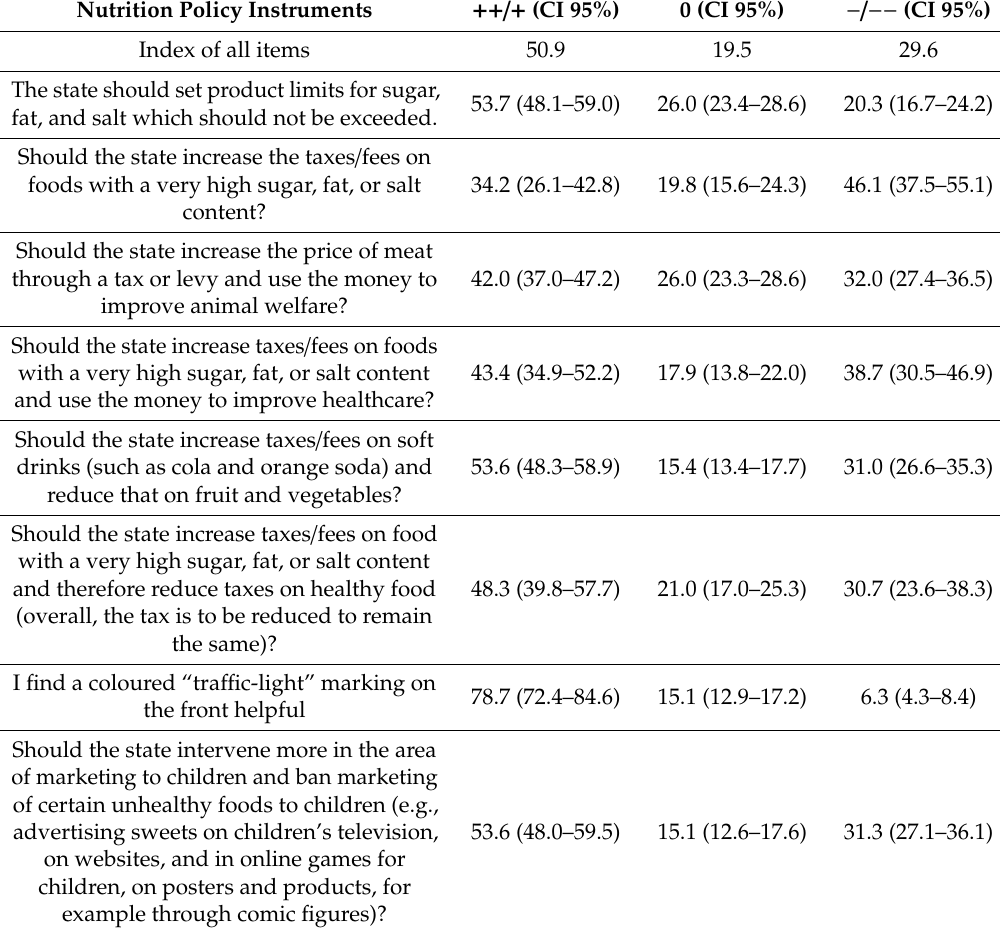
Table A2. Top box values and confidence intervals of cluster descriptive